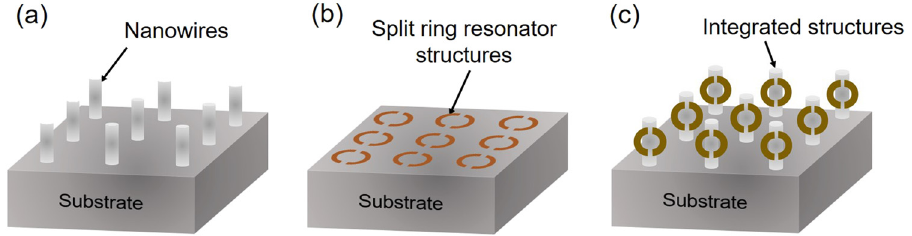
Figure 4: The antenna array made up of metamaterials with di ff erent structures and di ff erent electromagnetic properties. ( a ) The nanowires of metamaterials have a negative permittivity value and a positive permeability value. ( b ) The metamaterials have a structure of split ring resonator composed of two concentric metallic rings and separated by a gap. They have a positive permittivity value and a negative permeability value. ( c ) The nanoantennas element has an integrated structure of the nanowire and the split ring resonator. The metamaterials have a negative permittivity value and a negative permeability